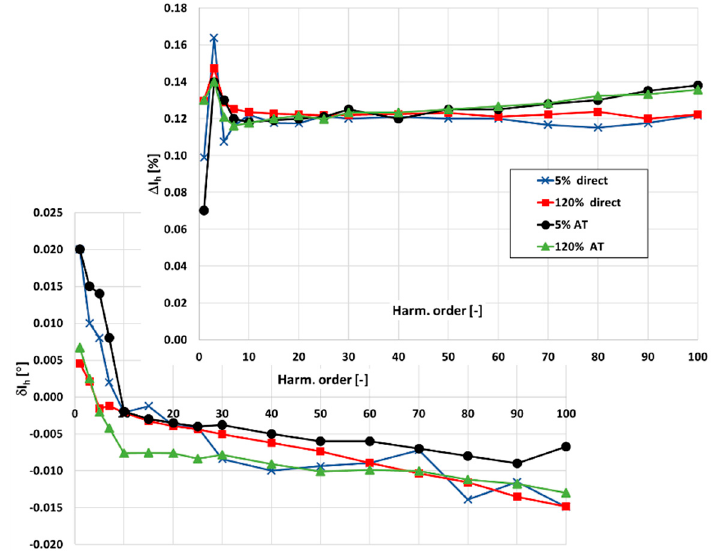
Figure 10. The comparison of the values of current and phase errors at harmonics of the tested CT 300\1 A obtained in relation to the designed CT and in conditions of ampere-turns.